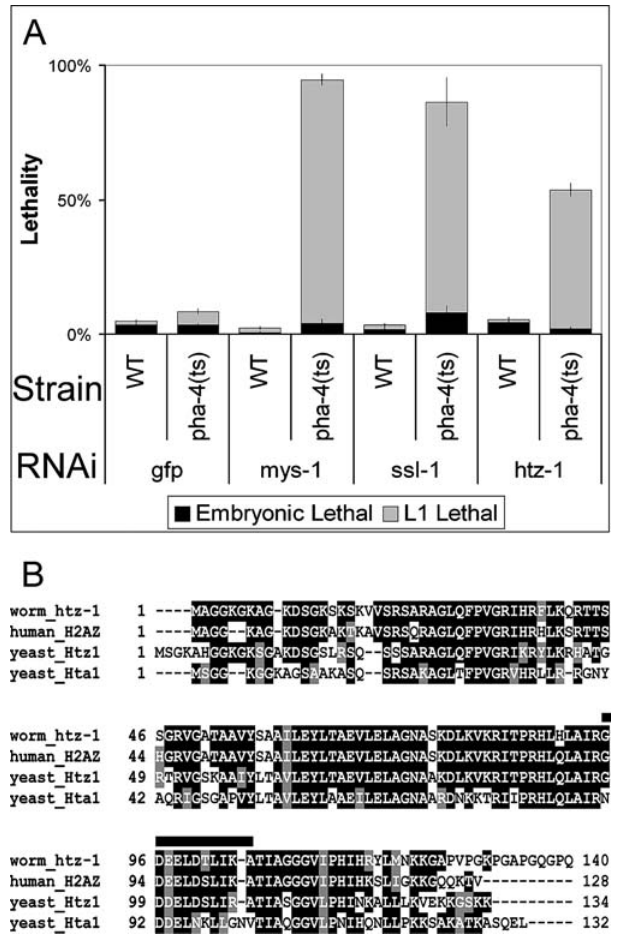
Figure 1. Enhancement of pha-4(ts) by mys-1, ssl-1, and htz-1 (A) Feeding dsRNA to wild-type (WT) or pha-4(ts) [18,25] worms at the permissive temperature of 24 8 C. WT worms generate viable progeny with mys-1, ssl-1 or htz-1 RNAi. In the pha-4(ts) background, L1 arrest increased with mys-1, ssl-1, or htz-1 RNAi compared to control GFP(RNAi) (grey bars). Embryonic lethality remained unchanged (black bars). Effectiveness of RNAi feeding was manifest through viable, but sterile, progeny for mys-1 and ssl-1 [14], as well as repeated enhancement of L1 lethality for pha-4(ts), performed in parallel. n ¼ 100 worms/plate, three plates per column. Error bars indicate the standard deviation. (B) Alignment of C. elegans htz-1 (R08C7.3) with human H2A.Z, yeast Htz1, and one of the core H2A genes from yeast, Hta1. Extended acid patch region essential for H2A.Z function is indicated by the